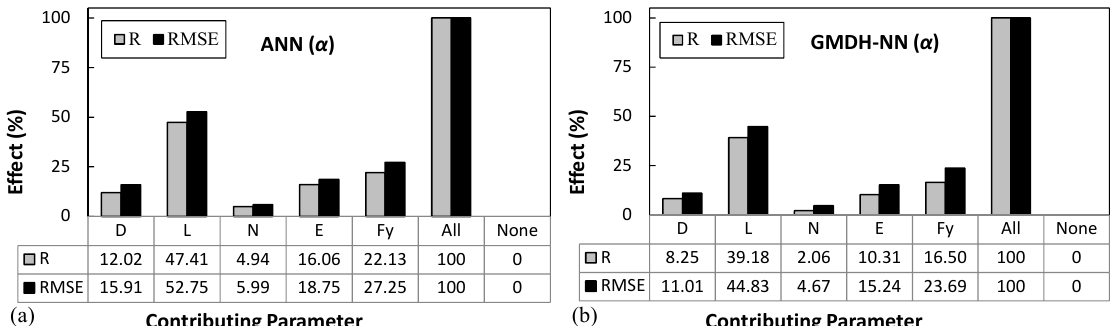
Figure 22. The effect of the input parameters on α estimation by considering R and RMSE values in proposed models: ( a ) ANN; ( b ) GMDH-NN.